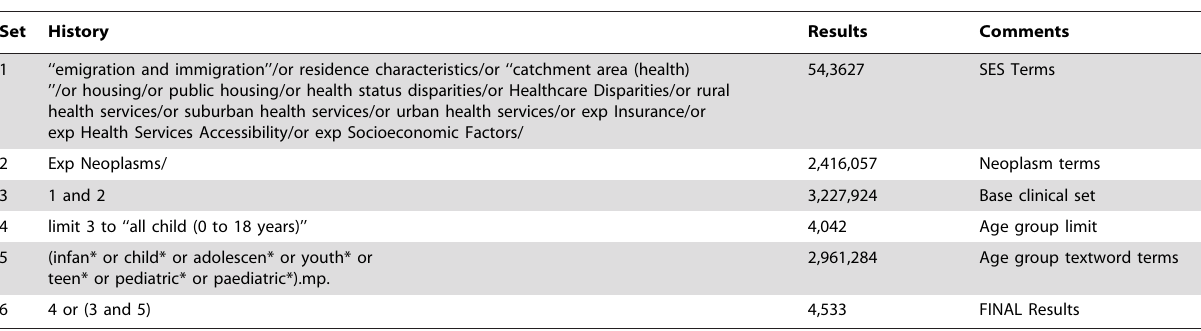
Table 1. Medline Search Strategy.